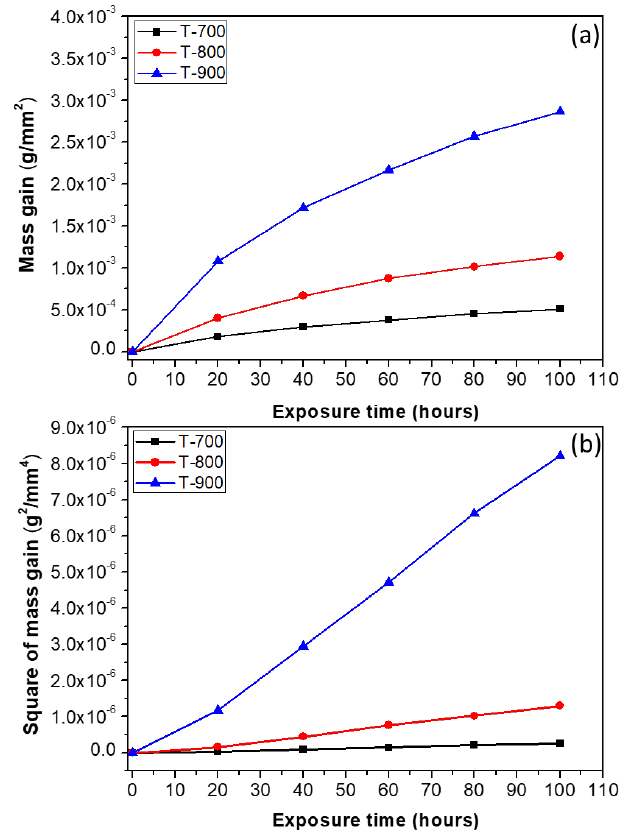
Figure 1. Curves of ( a ) mass gain vs. exposure time and ( b ) square of the mass gain per unit area vs. exposure time for the oxidized Ti samples at various